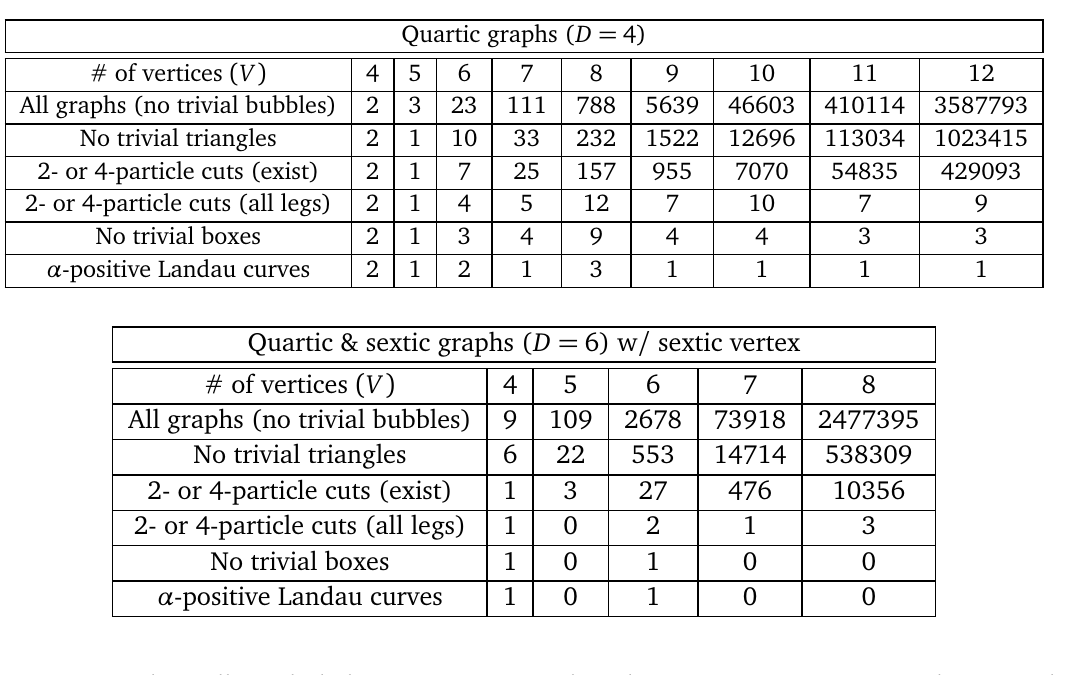
Table 1: The number of graphs with vertex degree 4 (top) and vertex degree ≤ 6 with at least one sextic vertex (bottom). Each column specifies the number of vertices and each row specifies a reduction step. We show the total number of 2 → 2 graphs without trivial bubbles in the second row. In the third row, graphs with trivial triangle subgraphs have been discarded. Next, we require that all legs can be put on-shell with at most 4-particle cuts since we are looking for Landau curves in the ( 4 family. We first demand that there exists at least one such cut of the diagram in each channel (fourth row). Next we demand that every line can be cut with a 2-particle or a 4-particle cut (fifth row). As a next step we discard the graphs containing a trivial box subgraph (sixth row). The last row has the number of graphs for which an α -positive solution has been found by numerically solving the Landau equations. For quartic graphs, this number does not go to zero as the number of vertices is increased. This is due to an infinite family of diagrams generated by consecutive insertion of triangles (see figure 4). The corresponding Landau curves accumulate at finite s , t , see figure 5. Current computational limitation prevents us from increasing the number of vertices any further, but we believe that all the relevant diagrams have been